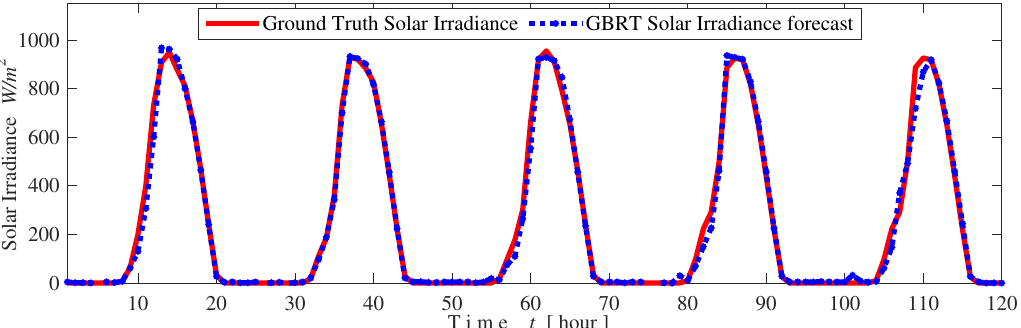
Figure 7. Comparison of the actual versus the predicted solar irradiances with one-hour-ahead rolling forecasting horizon using the GRBT forecasting model at α gbr = 0.1 (from 1/12/2018 to 5/12/2018).